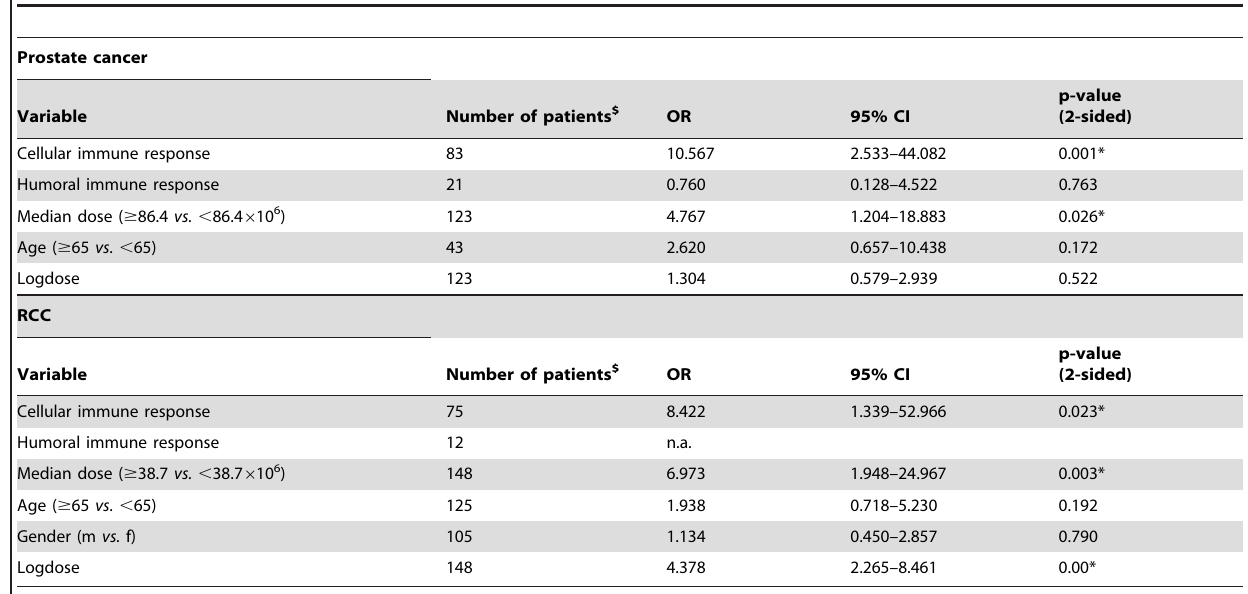
Table 2. Meta-analysis of influence on clinical benefit rate - conditional logistic regression grouped by study.